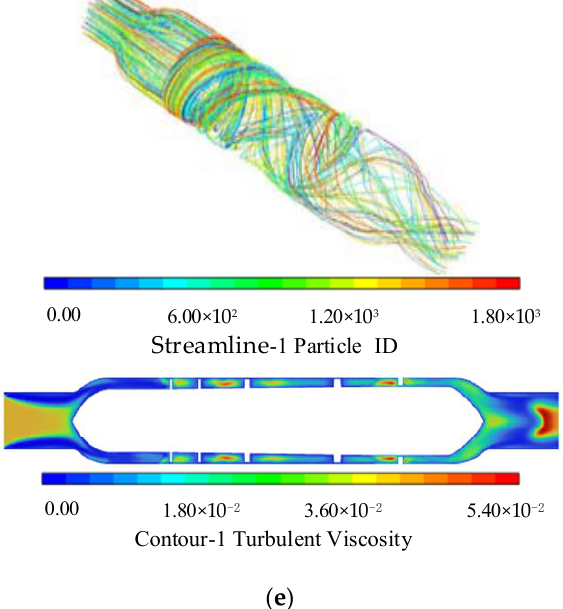
Figure 10. Streamline distribution and turbulent viscosity when the rear guide wheel has ( a ) two blades, ( b ) three blades, ( c ) four blades, ( d ) five blades, and ( e ) six blades.